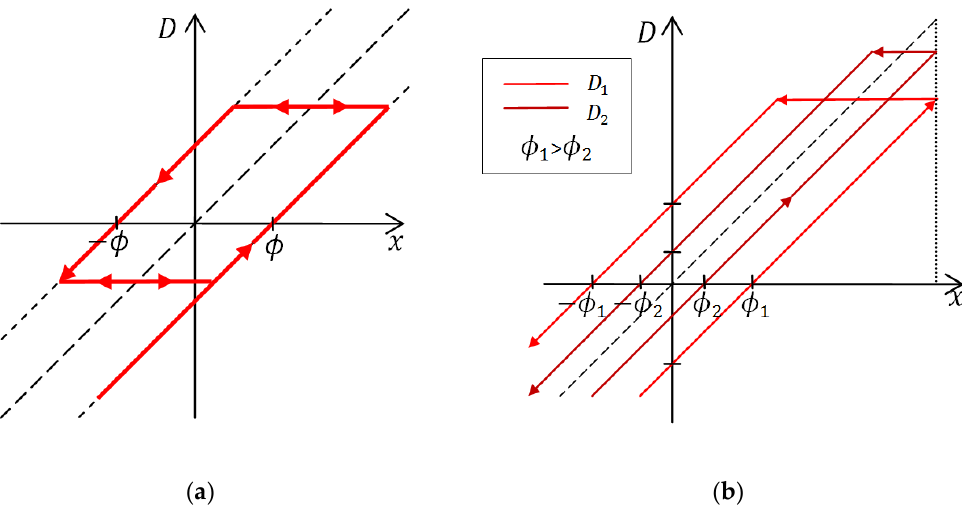
Figure 2. The ordinary play operator is used to describe the mathematical domain response to direction of external magnetic field x . ( a ) The value of the domain D does not change unless the difference between x and D exceeds the value of parameter ϕ . In that case, the domain response follows one of the dotted lines with a unity slope. ( b ) Responses of two different domains to the change in the direction of movement where φ 1 > φ 2 . The sensor was first moving upwards and then downwards along the scale.